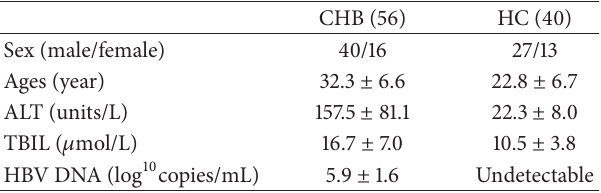
Table 1: Characteristics of CHB patients and control